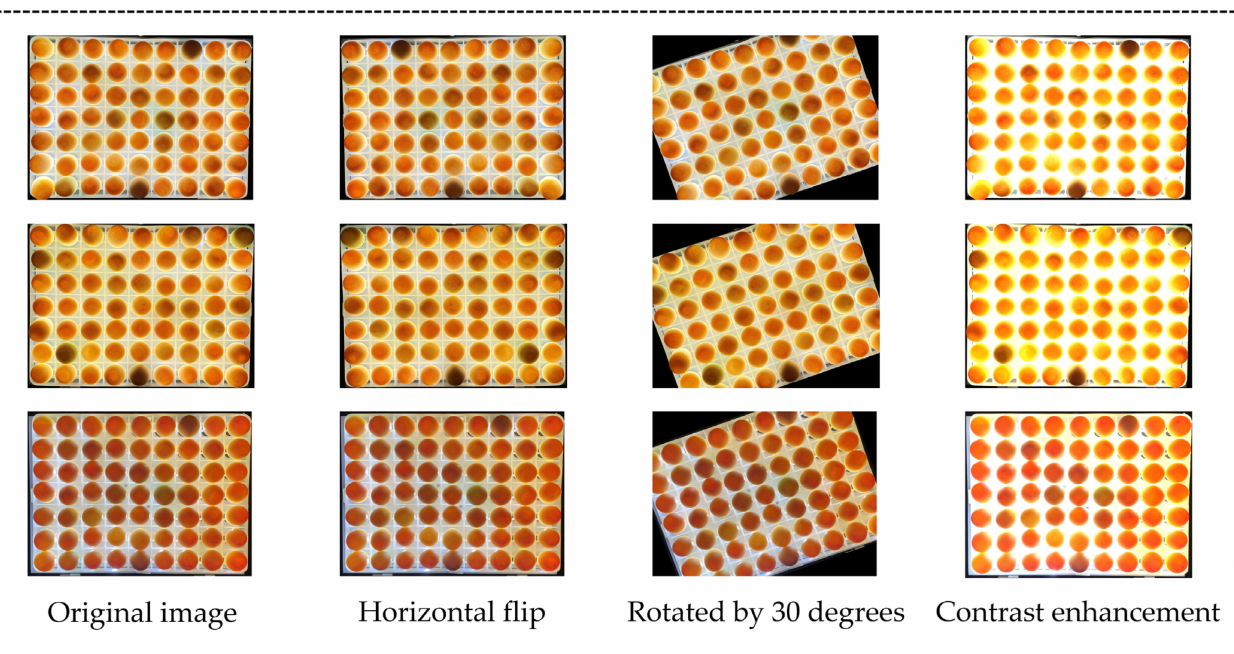
Figure 2. Examples of enhanced images used to simulate problems in analysis.